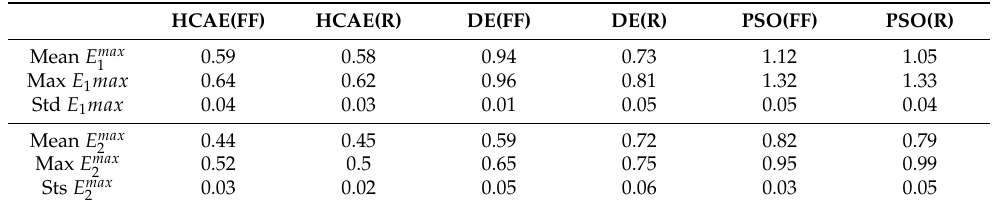
Table 10. Results of experiments on TFP.